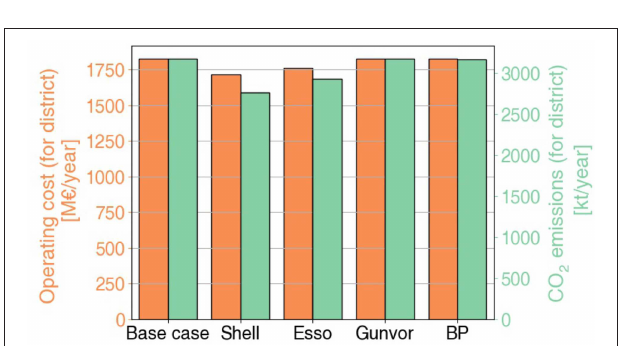
FIGURE 15 | Operating cost and CO 2 emissions, refinery/cement plant couples considered